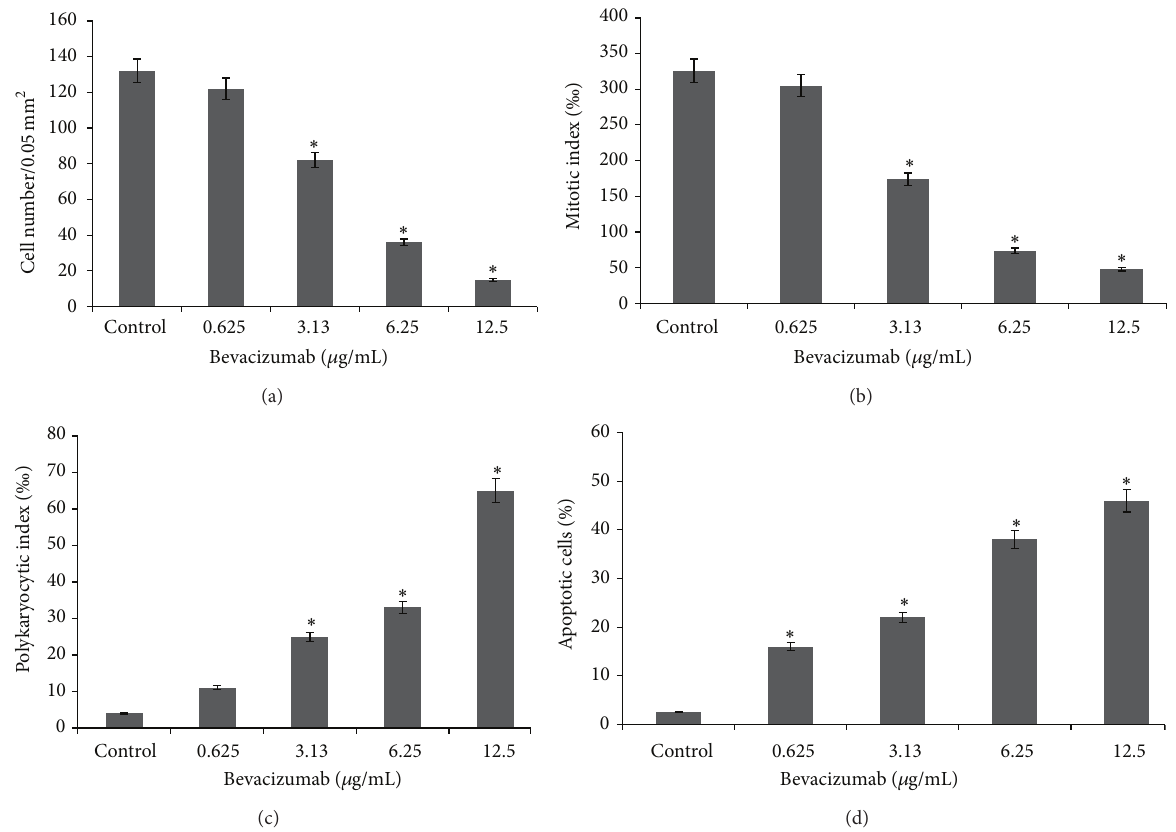
Figure 5: Kinetics of cellular proliferation (a), mitotic activity (b), polykaryocytic index (c), and apoptosis (d) in L929 cells treated by bevacizumab at different concentrations (data shown are at Day 5 of the treatment; 𝑛 = 3 , ∗ 𝑃 < 0.05